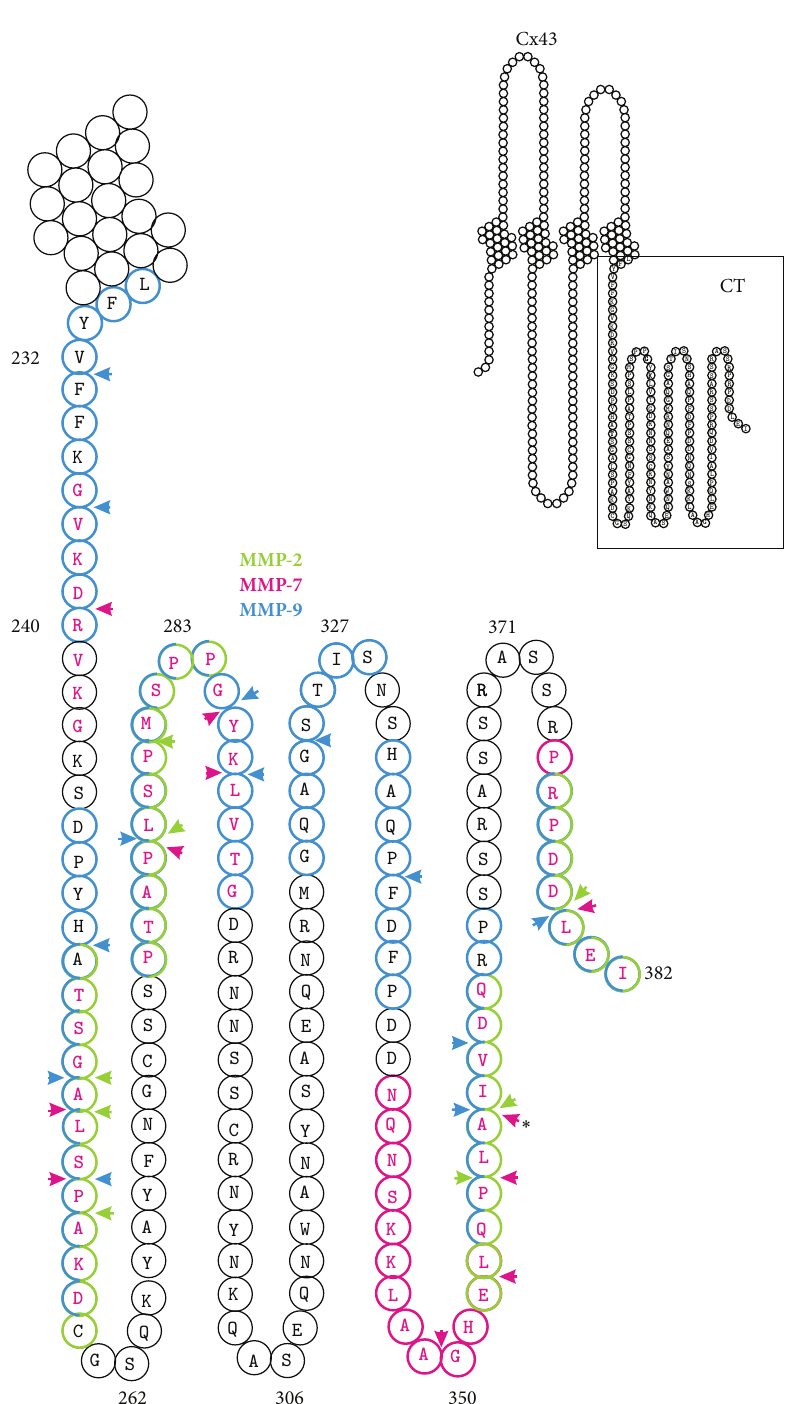
Figure 1: Predicted MMP cleavage sites of the Cx43 C-terminal domain. In silico analysis using PROSPER and SitePrediction reveals several potential cleavage sites of MMP-2 (green circles), MMP-7 (pink letters), and MMP-9 (blue circles) in the human Cx43 C-terminal domain. MMP target domains are 8 amino acids in length (P4-P3-P2-P1-P1 󸀠 -P2 󸀠 -P3 󸀠 -P4 󸀠 ) with the actual MMP cleavage site (between P1 and P1 󸀠 ) indicated by the arrowhead. In addition, we include one MMP-7 target site published in [7] that is not predicted by in silico analysis using PROSPER or SitePredict (indicated by the asterisk). Inset depicts the full length topology of